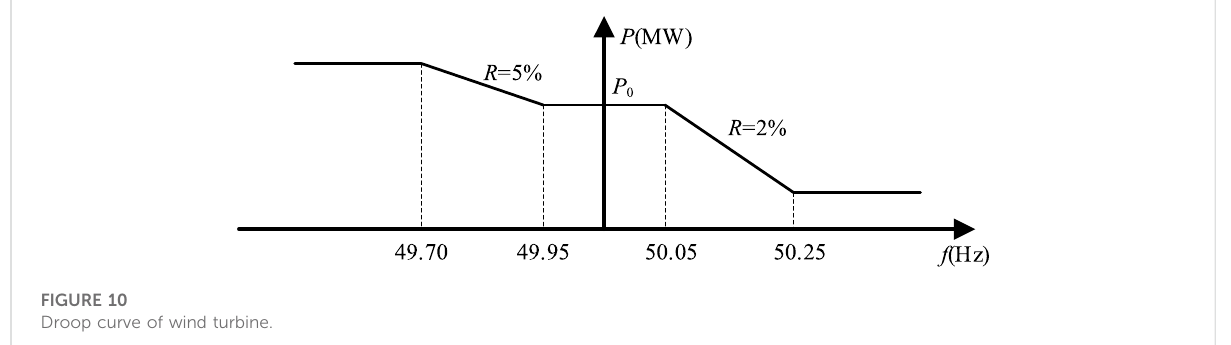
FIGURE 10 Droop curve of wind